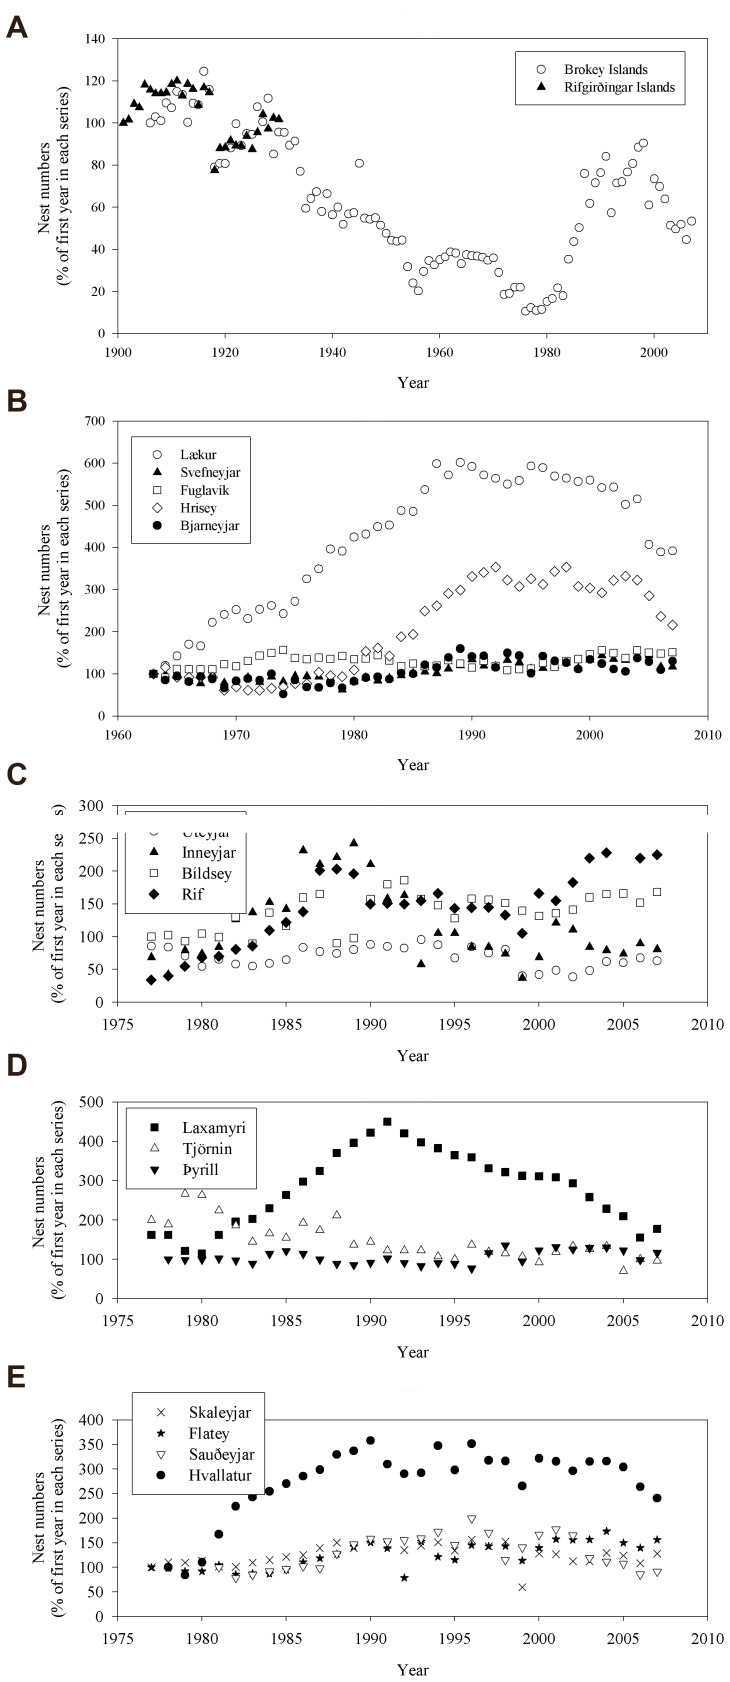
Variation in the numbers of breeding common eider Somateria mollissima in 17 colonies in Iceland.Breeding numbers are shown during (A) 1901–2007, (B) 1963–2007, (C, D, E) 1978–2007. Y-axis shows breeding numbers which were standardized by setting the first year of each series at 100%. Note the differing scales on y- and x axis.